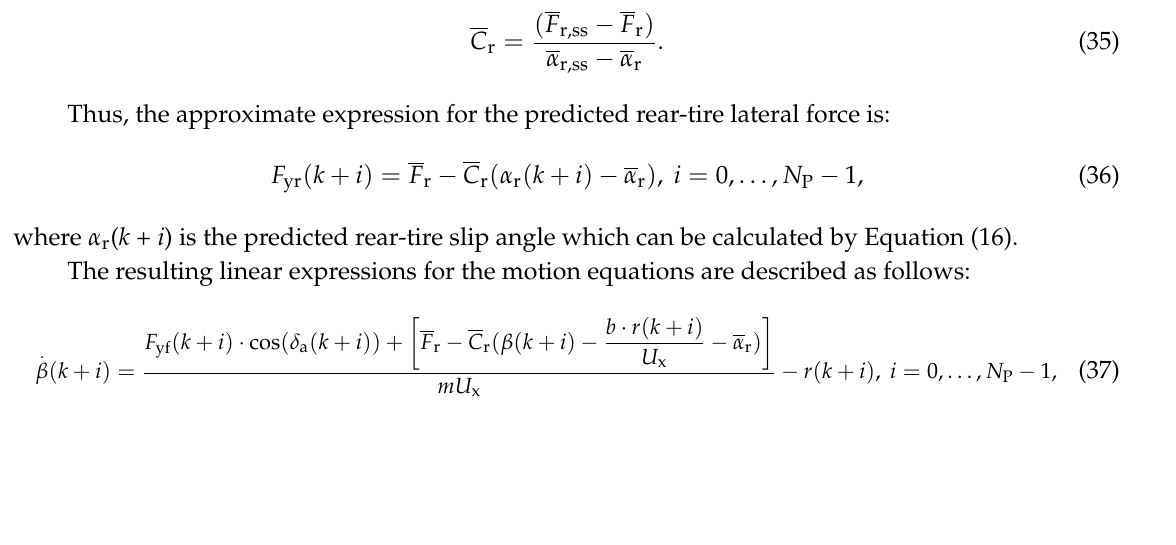
Figure 4. Linear approximation of the brush tire model. α r and α r,ss are the tire slip angle at time k and steady-state tire slip angle at step N P of the prediction horizon, respectively. F r and F r,ss are the corresponding lateral forces.